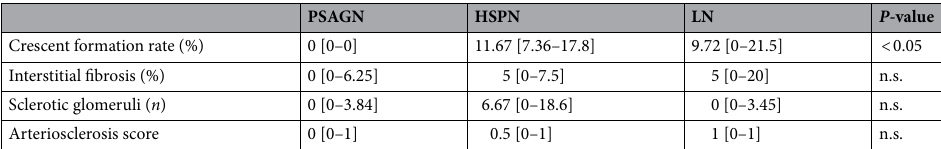
Table 2. Pathological characteristics. PSAGN, post-streptococcal acute glomerulonephritis; HSPN, Henoch– Schönlein purpura nephritis; LN, lupus nephritis; n.s., not significant.